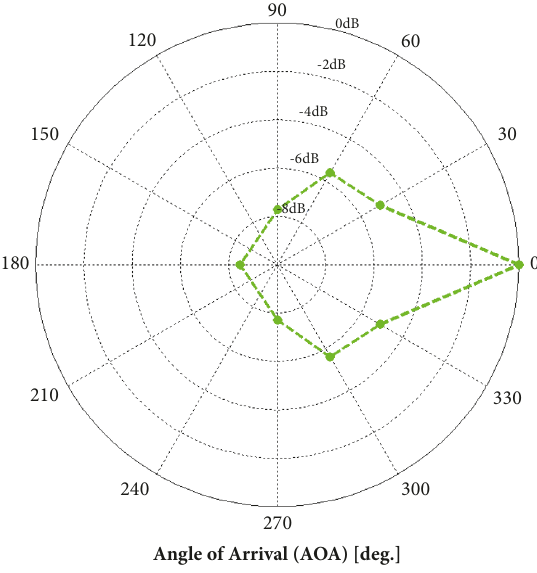
Figure 3: EasyHear Grand beamforming performance with device suspended in an undisturbed field (manufacturer